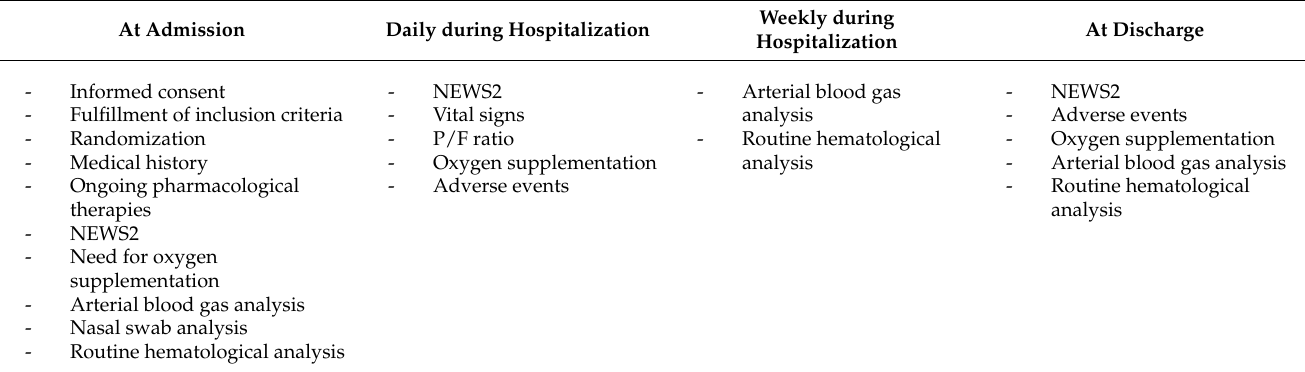
Table 1. Data collection frequency for the relevant